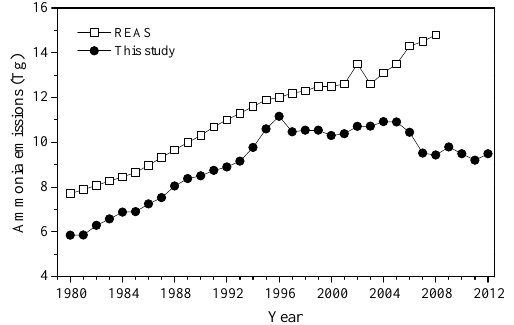
Figure 8. Comparison of NH 3 emissions from synthetic fertilizers between this study and